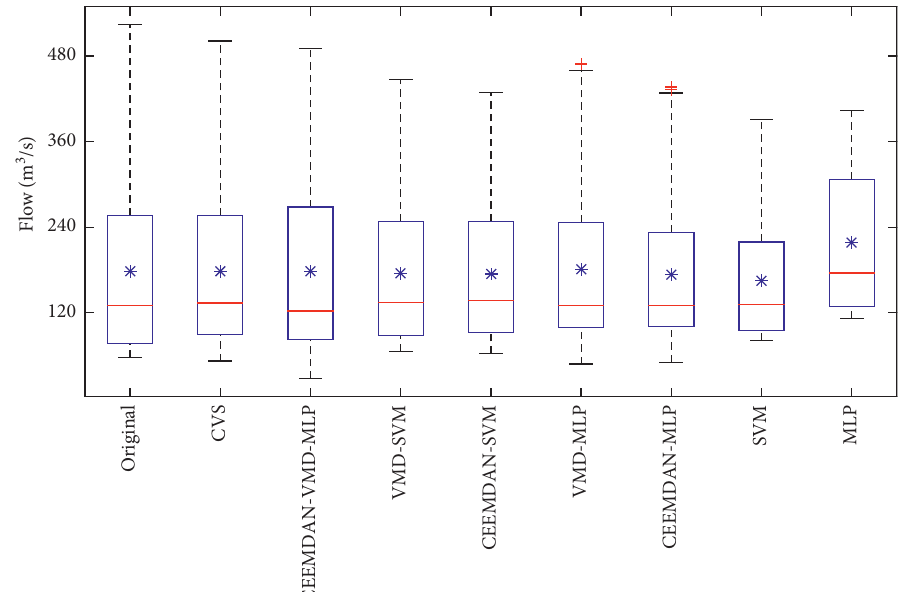
Figure 12: Boxplot of runoff during the training period for hybrid models and the benchmark model. The red line marks the median in addition to the mean (blue